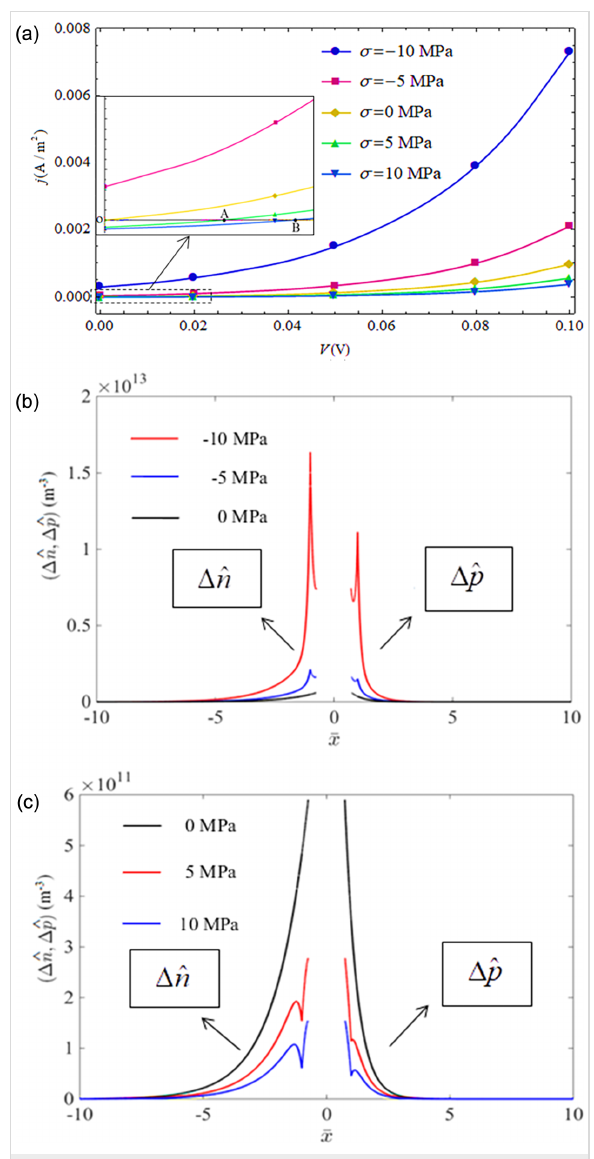
Figure 4: (a) I – V characteristics of a piezoelectric p–n junction under different loadings; (b) NEMC distributions at V = 0.05 V under different compressive loadings; (c) NEMC distributions at V = 0.05 V under dif- ferent tensile